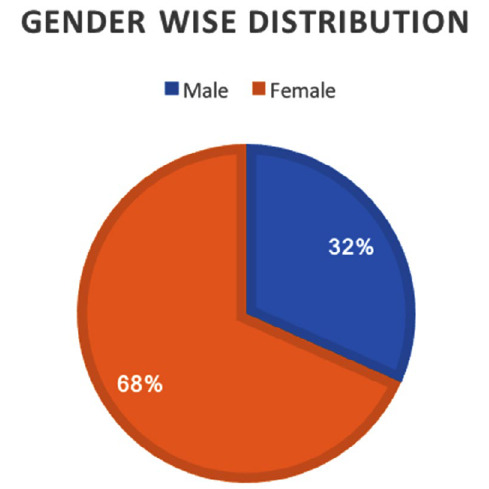
Fig. 2. Gender wise